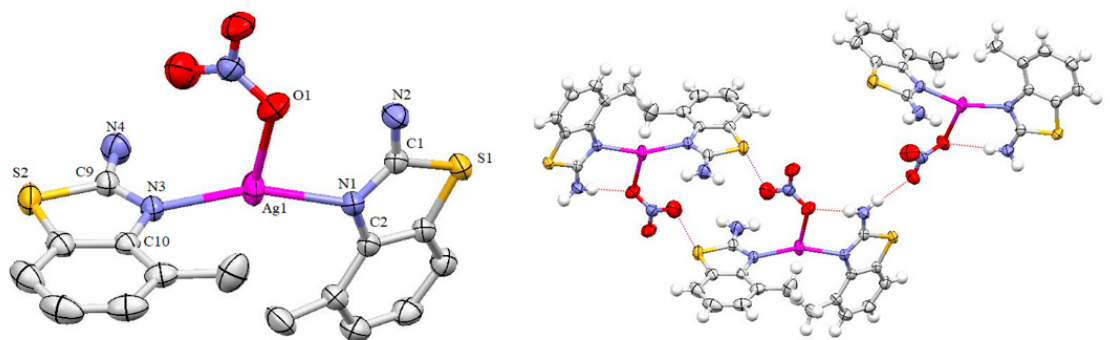
Figure 1. Solid state structure of 2 along with partial atomic numbering schemes ( left ), intermolecular H-bonding in molecules of the complex ( right ). Thermal ellipsoids are drawn at 50% probability level; H atoms are omitted in the molecule; color scheme: oxygen (red), nitrogen (light blue), sulfur (yellow), silver metal ion (purple) and carbon (grey).